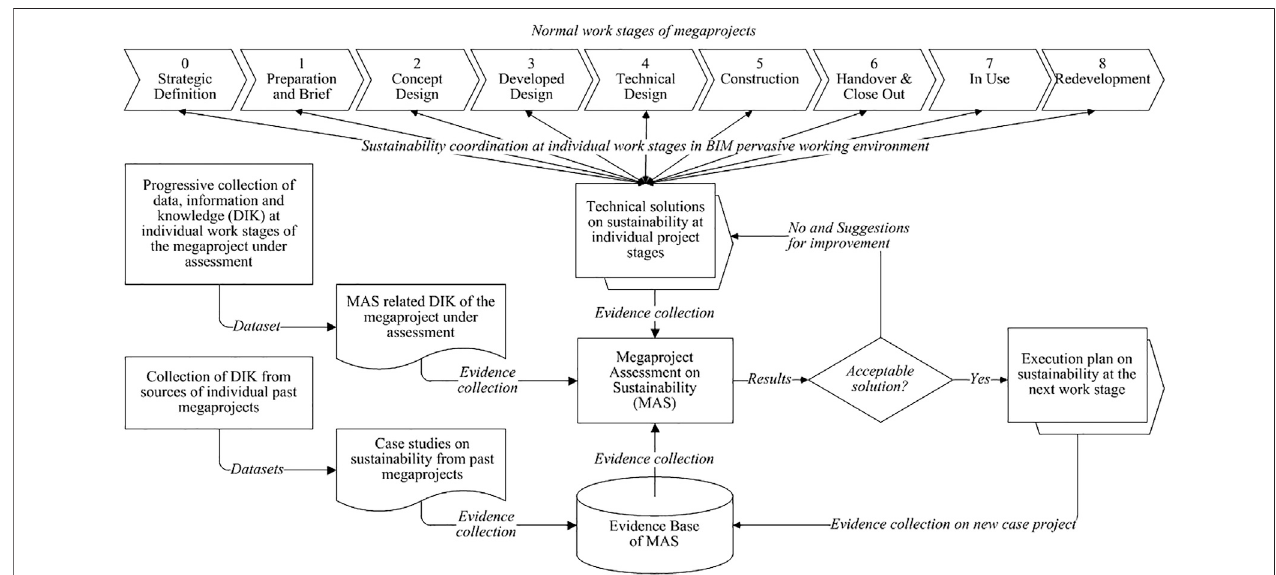
FIGURE 2 | An illustrated procedure of MAS.